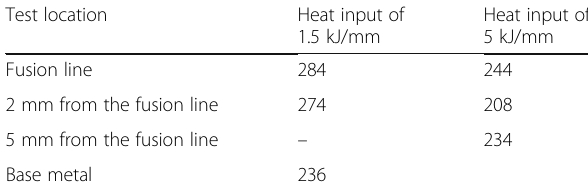
Table 8 Impact test values at − 40 °C of welded joints of steel